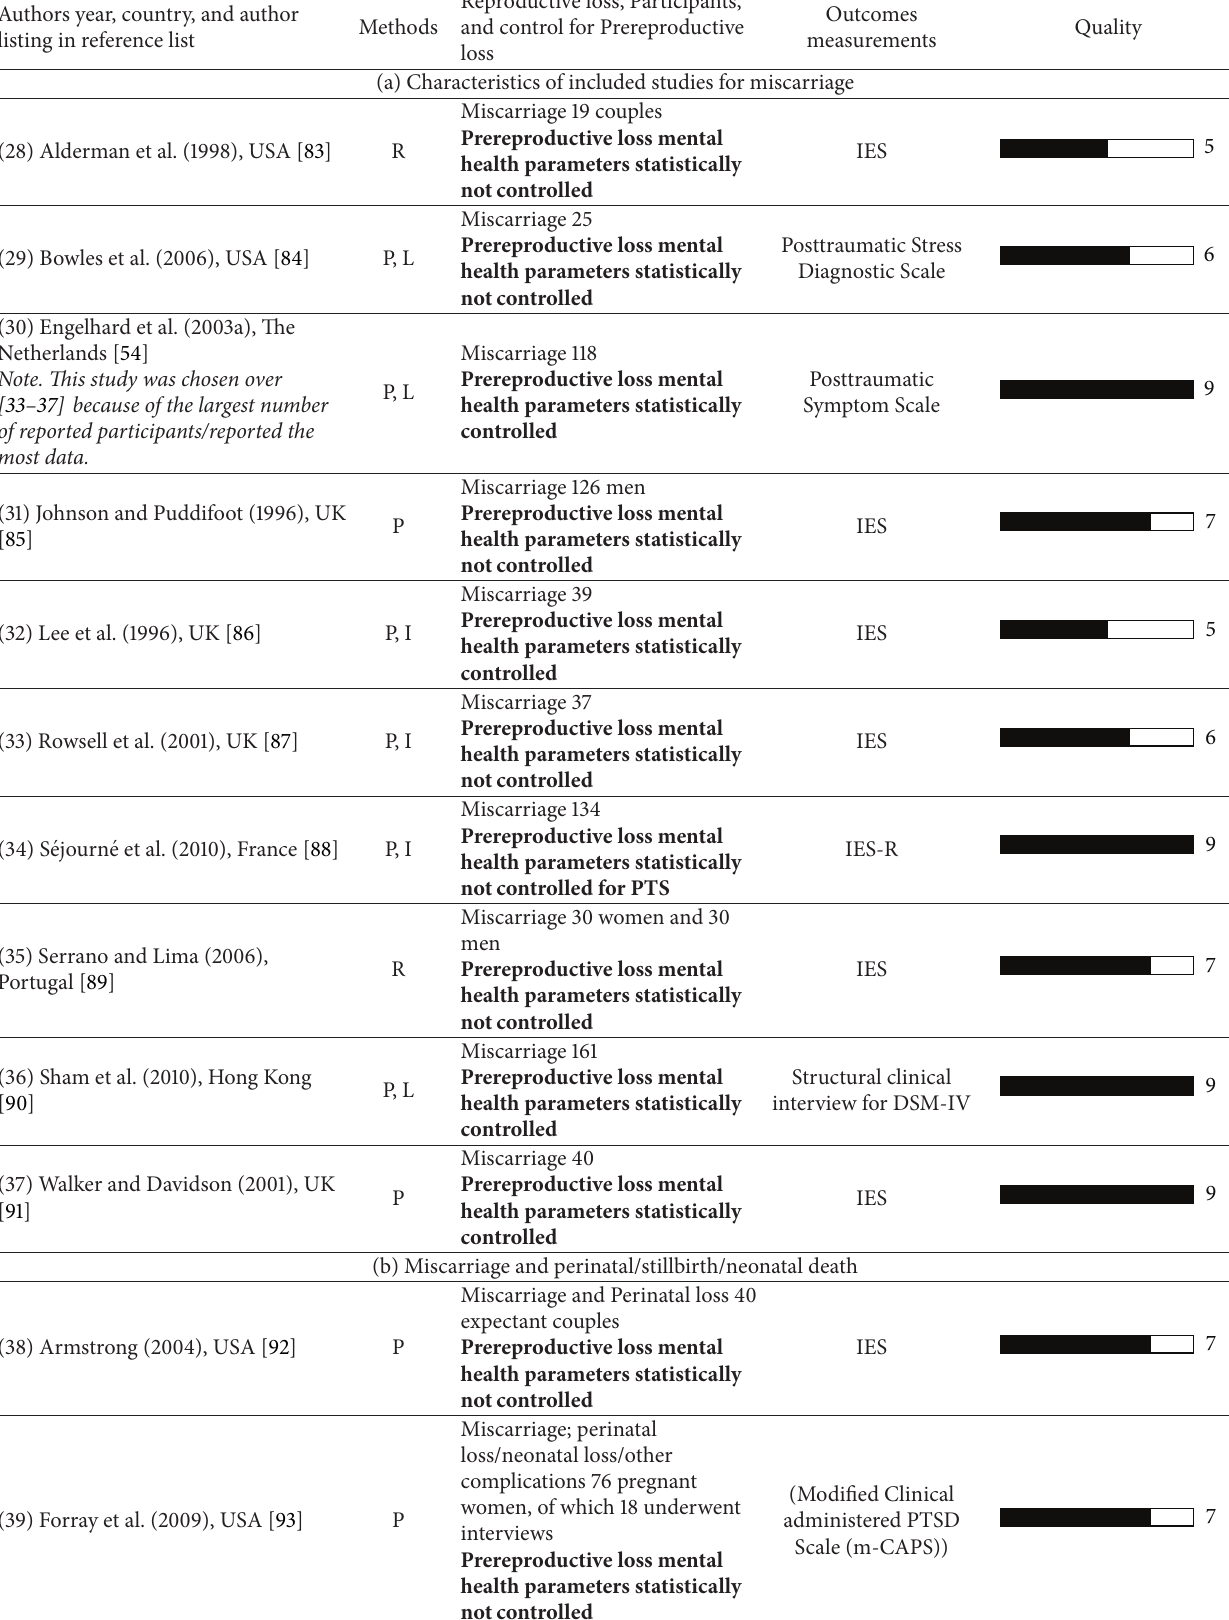
Table 2: Characteristics of included studies for miscarriage (a) and miscarriage with perinatal loss/stillbirth/neonatal death (b). Authors year, country, and